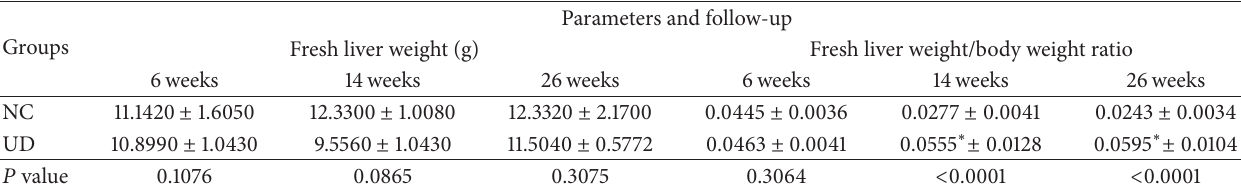
Table 3: Mean ± SD of fresh liver weight (g) and fresh liver weight/body weight ratio of nondiabetic control rats and untreated diabetic rats during the various experimental follow-up